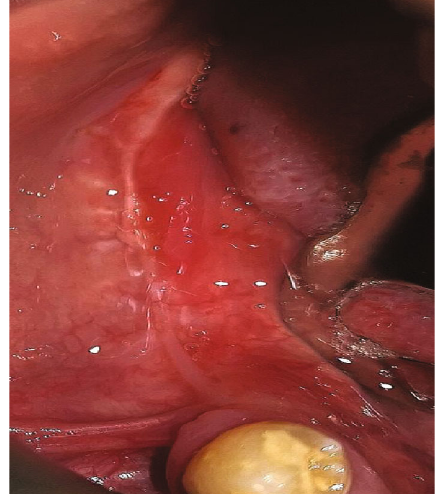
Figure 5: One-year postoperative intraoral photograph.